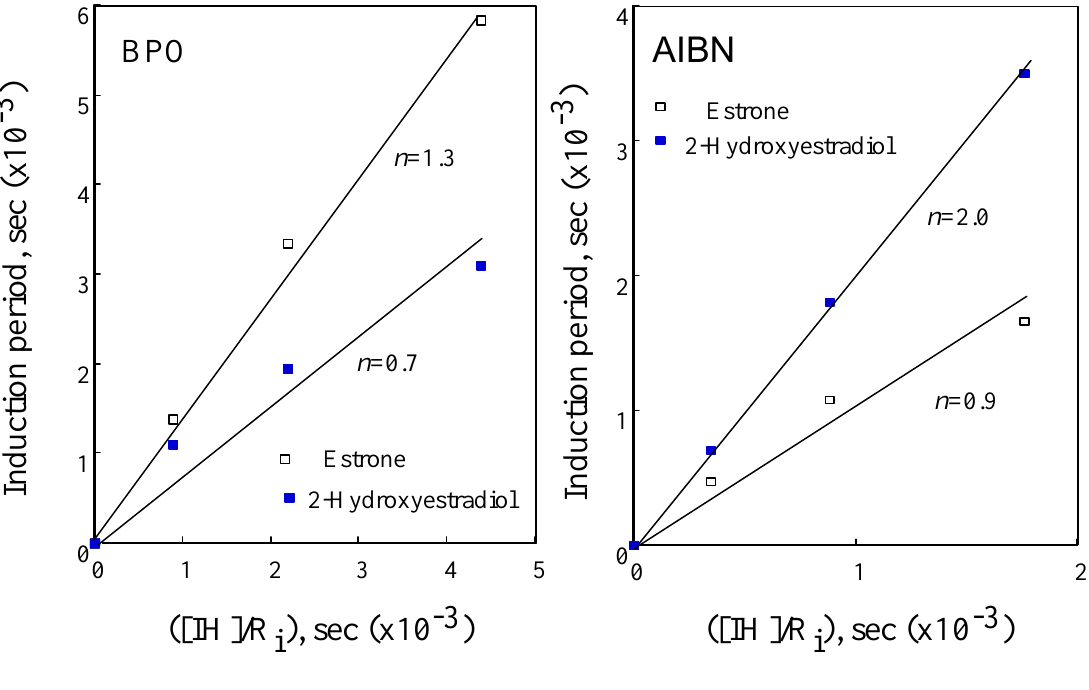
Figure 4. Plot of the induction period vs [IH]/R the AIBN and BPO system. [IH], concentration of estrogen inhibitor; R initiators. The slope for the induction period vs [IH]/R expressed as the mean of three independent experiments.